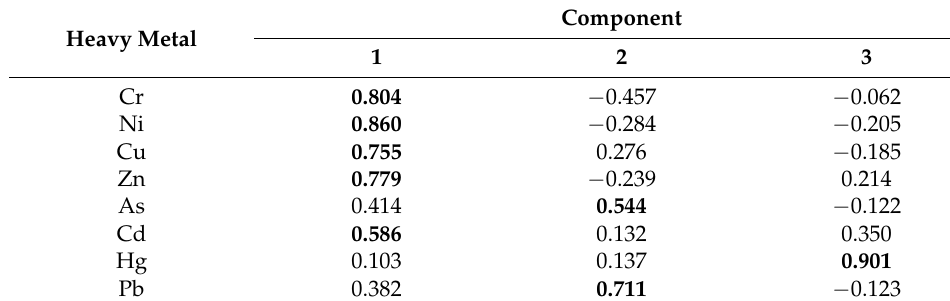
Table 5. Component matrix.